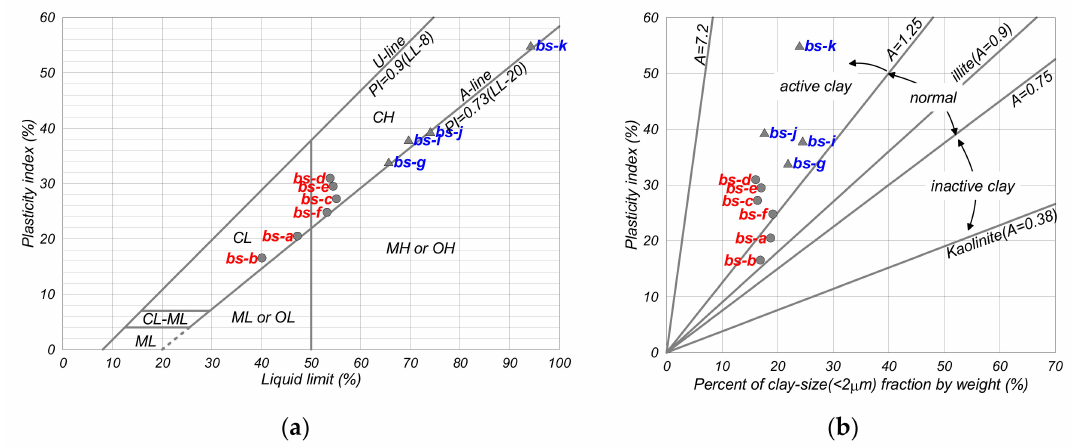
Figure 2. Physical properties of Busan region soil: ( a ) Plasticity chart; ( b ) Activity chart.